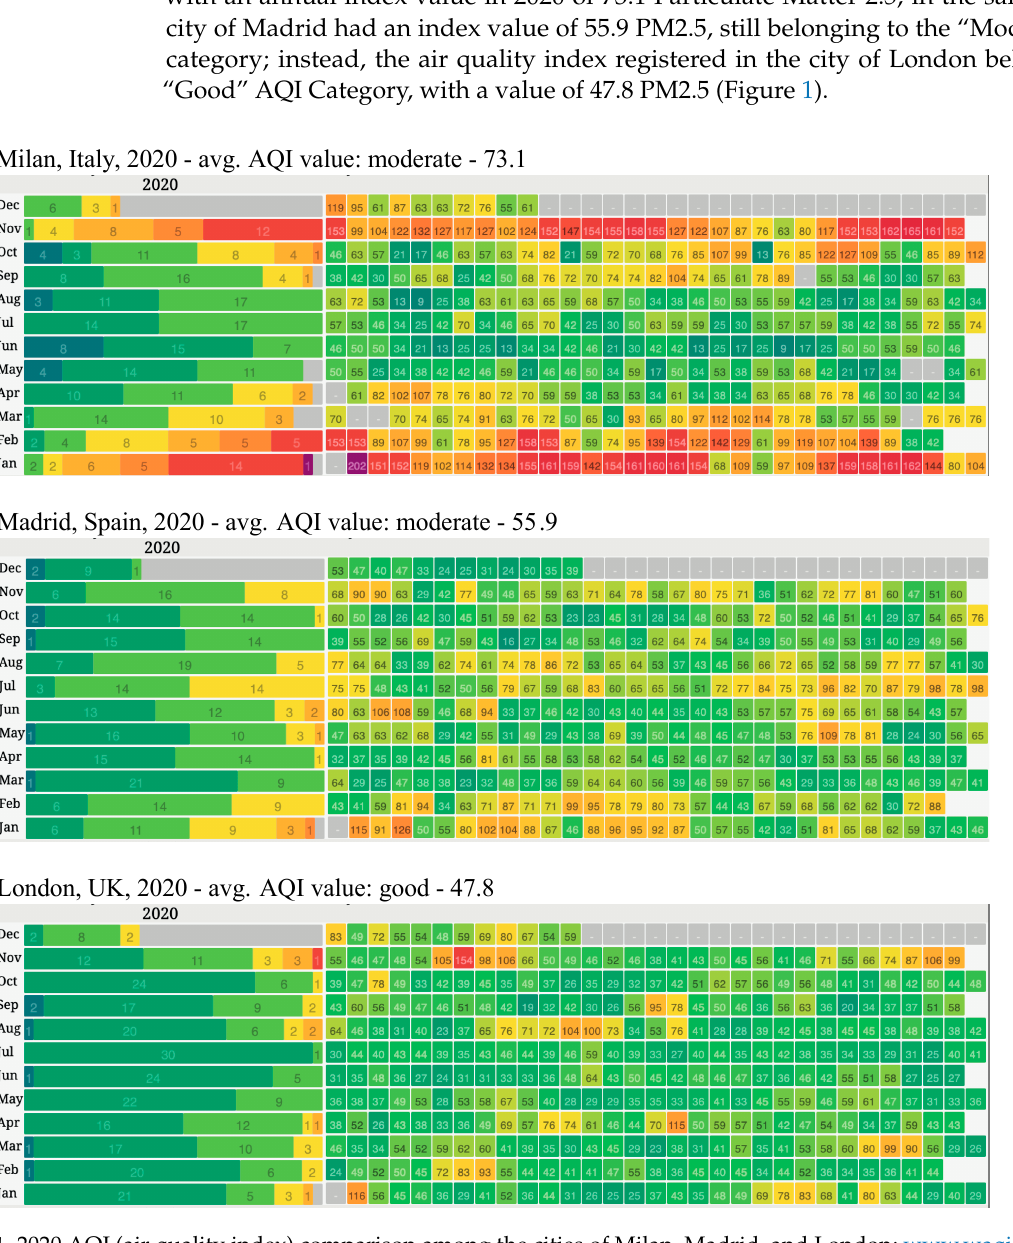
Figure 1. 2020 AQI (air quality index) comparison among the cities of Milan, Madrid, and London; www.waqi.info.